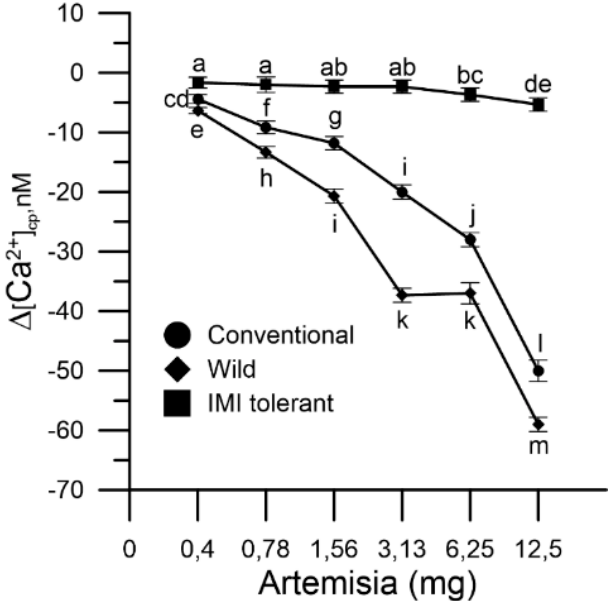
Figure 2. Effect of mugwort on levels of cytosolic Ca 2+ in sunflower pollen grains: conventional ( ● ), wild ( ♦ ) and ‘IMI-tolerant’ ( ■ ). Results are expressed as ∆ [Ca 2+ ]cp (nM) to reflect signal changes detected between the start and the end of the fluorometric measurements and represent means ± SEM from three independent tests. Statistically significant differences are indicated by different letters, whereas identical letters highlight non-significant trends. SEM, standard error of the mean.